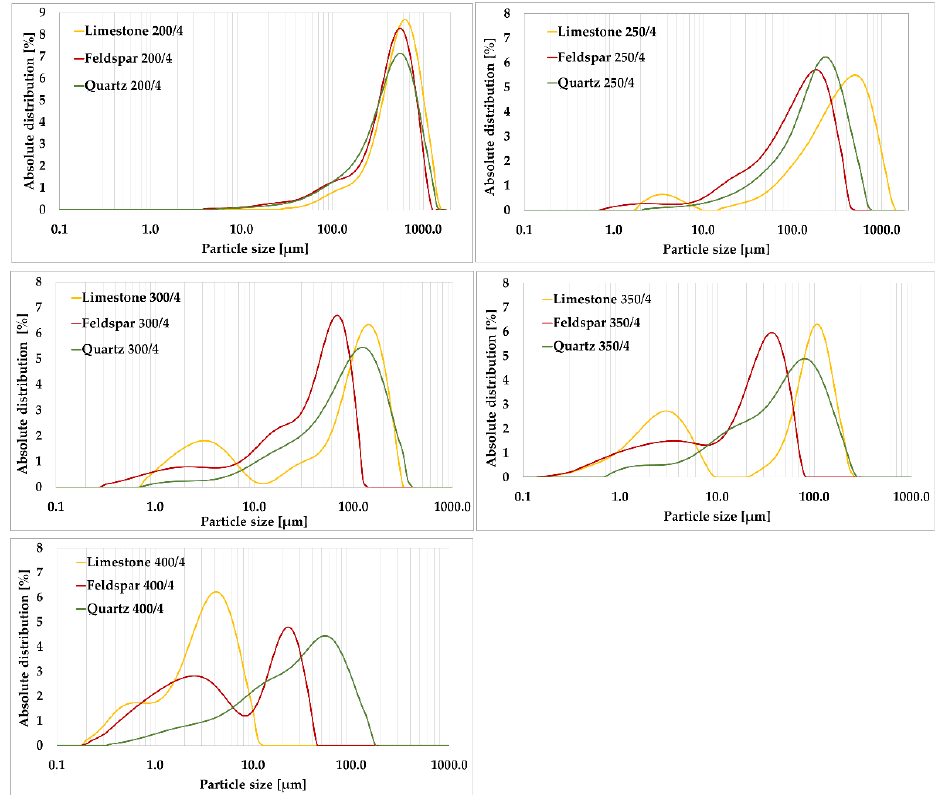
Figure 5. Laser granulometry of limestone, feldspar, and quartz under different milling regimes. From the laser granulometry plot, the curves achieve a steady increase in the content of crushed particles. There is no over-milling of any material. For the 250 rpm milling of limestone, a higher number of ultrafine fractions in the region of 0.001 to 0.010 mm were already produced. Furthermore, the content of ultrafine particles below 0.010 mm was determined to be almost twice as high in limestone as in feldspar. For limestone and feldspar, the content of particles below 0.020 mm was 6.12% and 8.98%, respectively. The difference was in the representation of individual particle sizes below 0.020 mm. For quartz, the value was determined to be 3.76%. Feldspar showed the highest value of 8.94% for grain size 0.063 to 0.090 mm. The lowest value was determined for limestone at 3.09%. It was verified that the milling time was selected optimally as there was no mineral over-milling and agglomerate